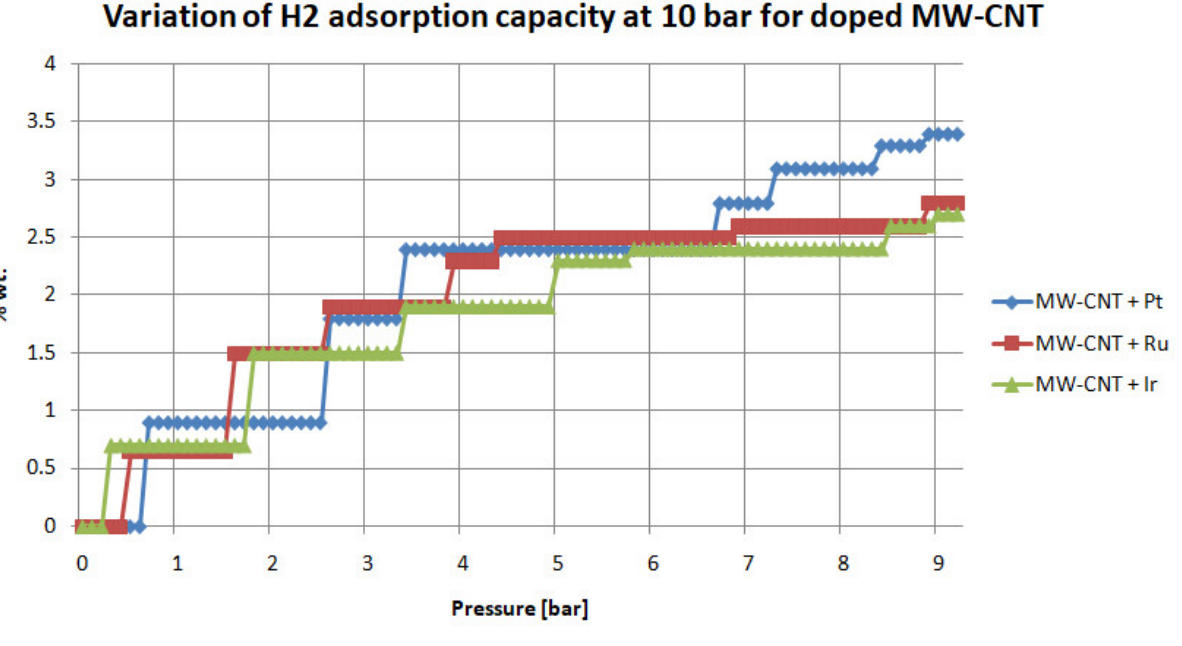
Figure 6. Metal-doped MW-NT H 2 -adsorption-capacity determination at 20 bar.